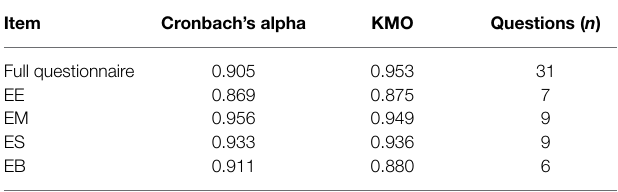
TABLE 1 | Reliability test of the